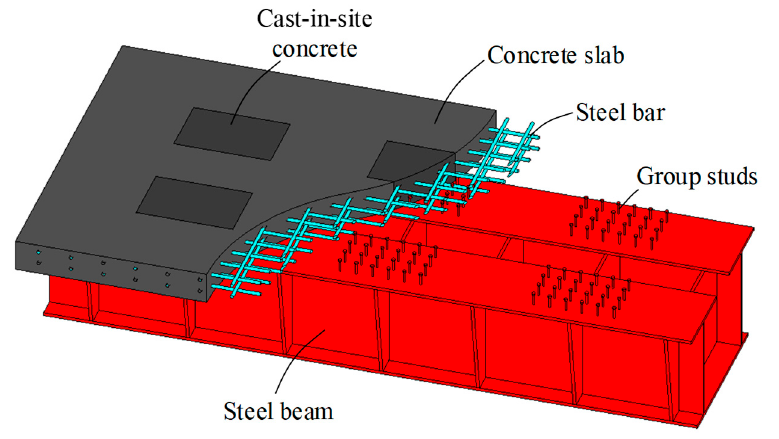
Figure 1. Prefabricated steel ‒ concrete composite beams.